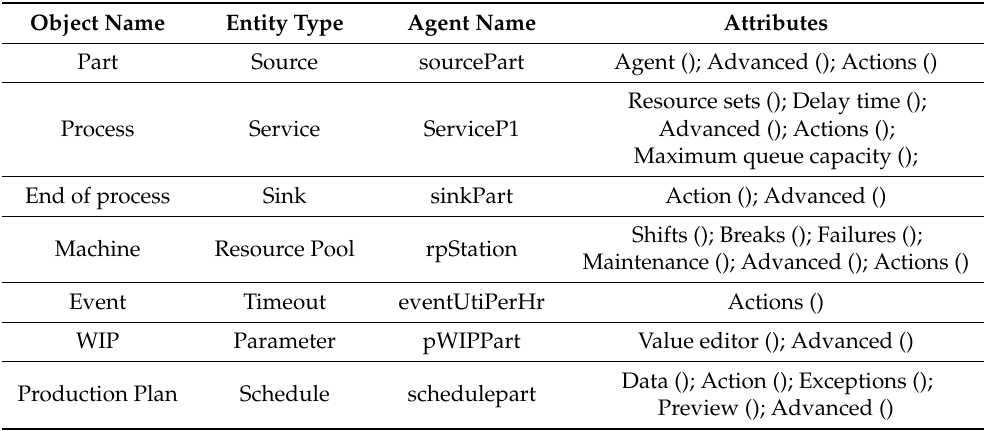
Table 4. Created Module Parameters.